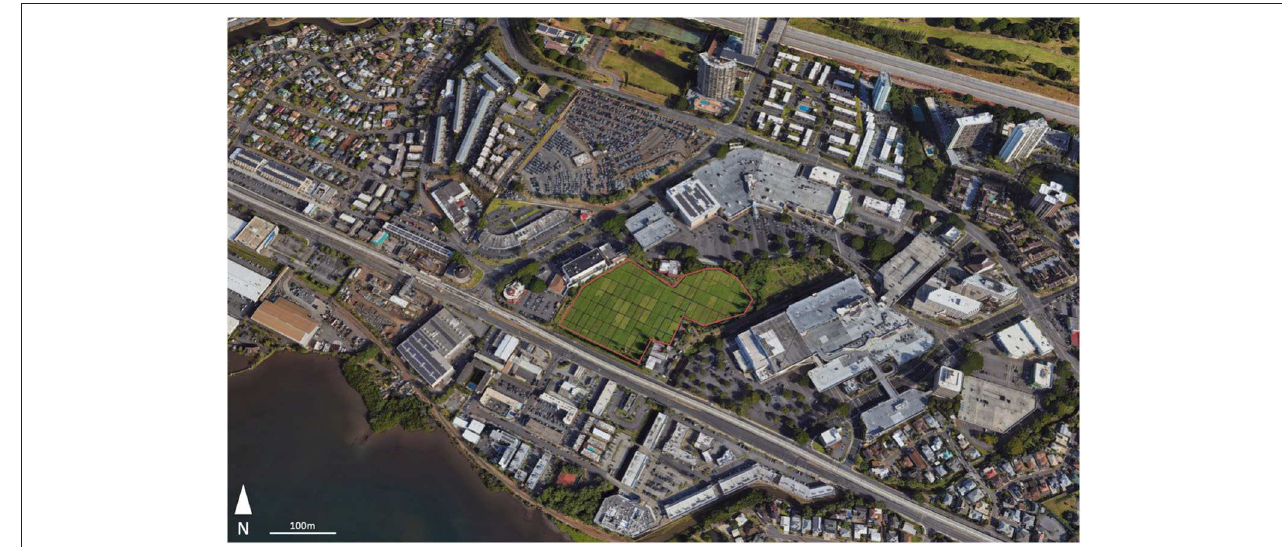
FIGURE 3 | Sumida Farm (orange outlined area) in the highly urbanized Pearl Harbor area.